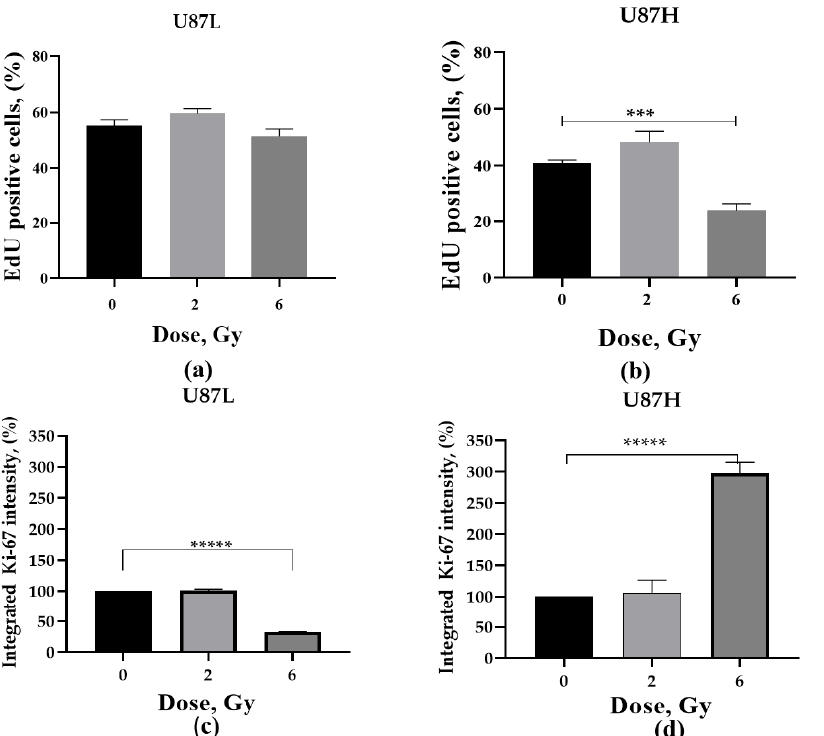
Figure 4. Assessment of the proliferative activity of minimally cultured U87L ( a , c ) and long-term cultured U87H cells ( b , d ). Change in the percentage of EdU+ cells ( a , b ), as well as change in the Ki- 67 fluorescence intensity (%) ( c , d ) was measured 24 h after irradiation at doses of 2 and 6 Gy. ** p < 0. 01; ***** p < 0.0001. *** p < 0.001; ***** p < 0.00001.